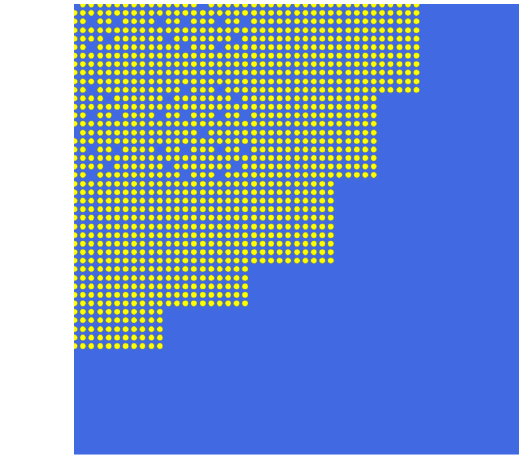
Figure 4: 1484 Core 1 Figure 5: 1810 Core 1